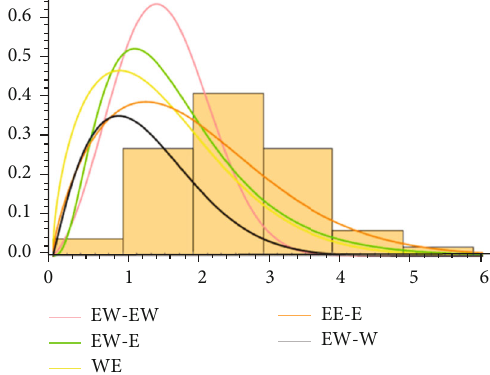
Figure 6: Plot PDF of the EW-EW, EW-E, WE, EE-E and EW-EW with the empirical distribution for the 2 nd